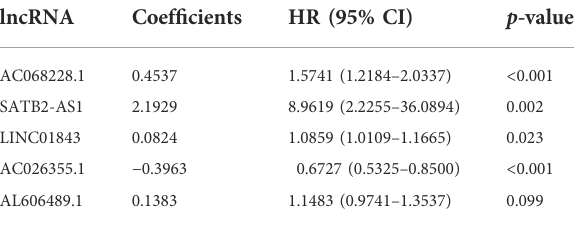
TABLE 2 Five OS-related lncRNAs in the “ primary dataset ”